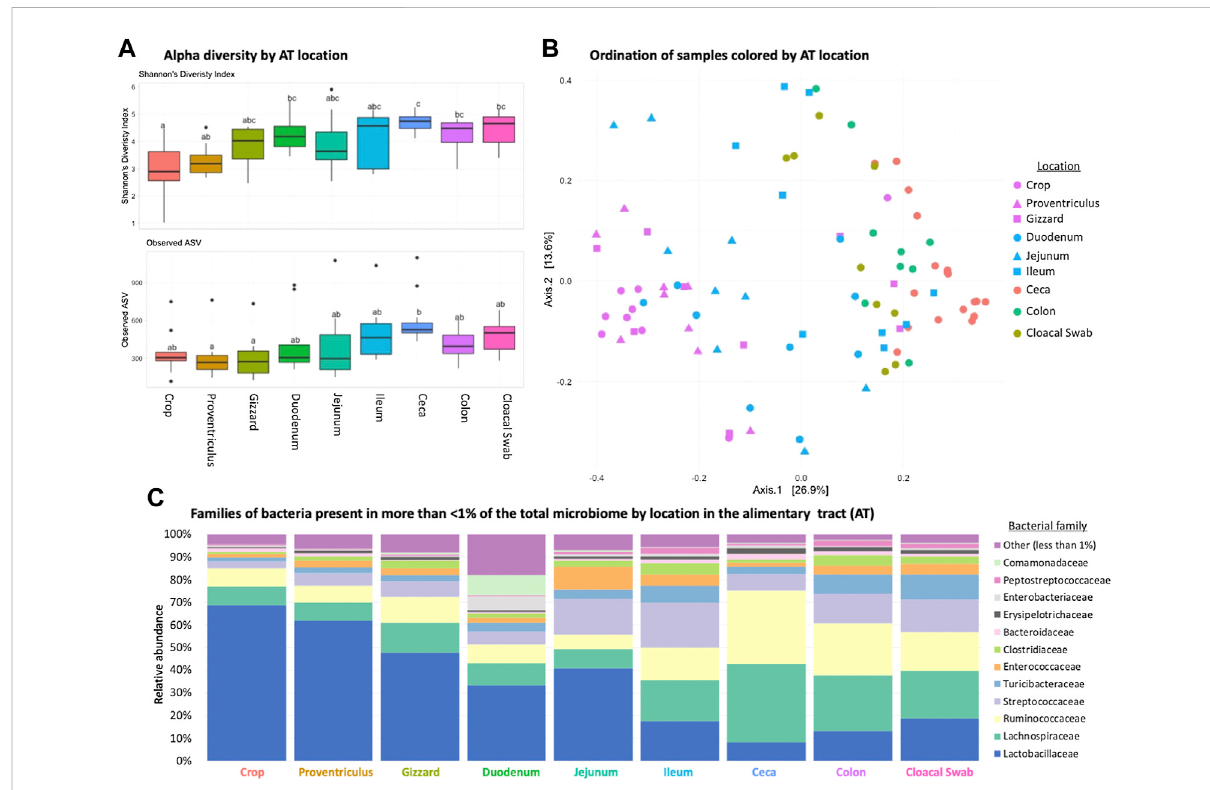
Differences in the broiler chicken alimentary tract (AT) by location. (A) Alpha diversity of AT locations in the birds; there were differences ( p < 0.05)betweenlocations. (B) BetadiversitydifferencesofATlocations;locationsweredifferent(ANOSIMR=0.6188, p =0.001). (C) Stackedbarchart of relative abundance of more prominent bacterial classes found in the AT by